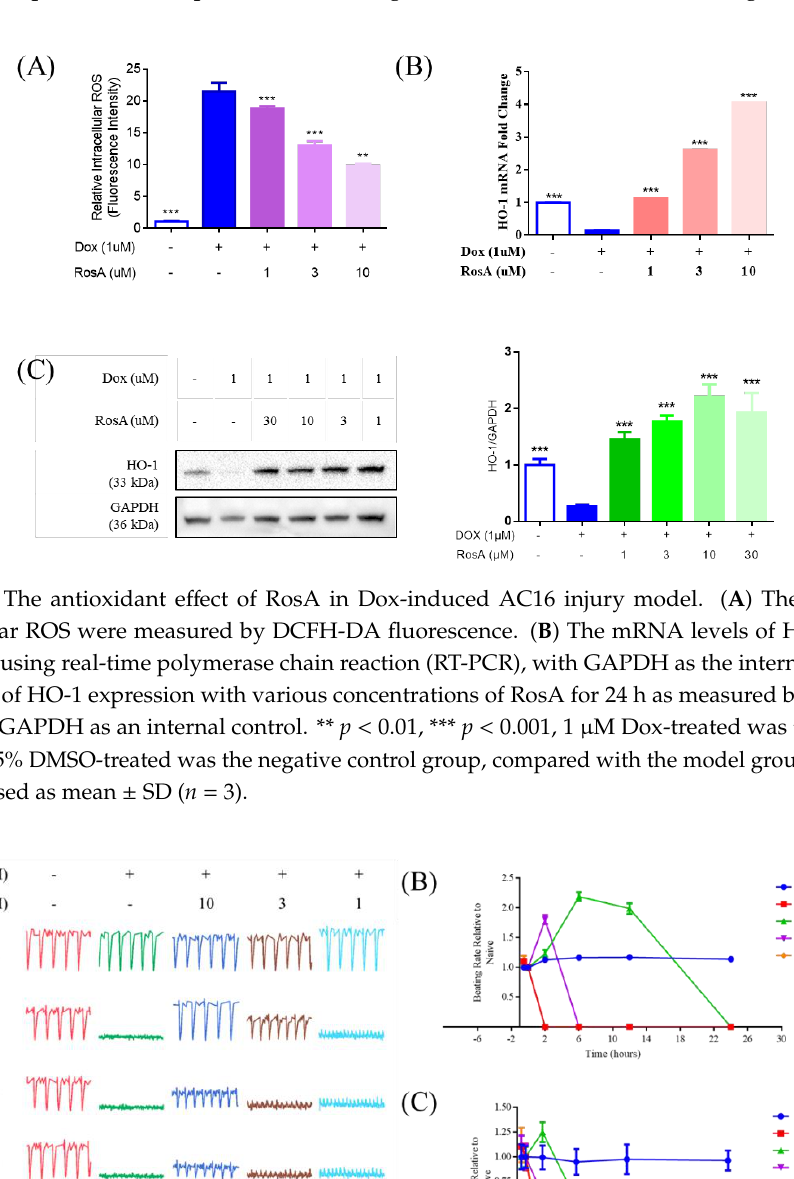
Figure 8. The myocardial protection of RosA in a Dox-induced hiPS-CMs injury model. ( A ) The levels of NT-proBNP and IL-6 were measured by ELISA. ( B ) The mRNA levels of NPPB and IL6 were evaluated using real-time PCR, with GAPDH as an internal control. ( C ) The levels of myocardial protection proteins, such as HDAC1, GATA4, and CTnI, were measured by Western blot, with β - tubulin as an internal control. * p < 0.05, ** p < 0.01, *** p < 0.001, ns: no significant difference. 1 μM Dox-treated was the model group; 0.25% DMSO-treated was the negative control group, compared with the model group. Results are expressed as mean ± SD ( n = 3). 3. Discussion The case study presented here illustrates the potential of phenotypic screening assisted by objective multivariable statistical methods. Pattern recognition techniques are particularly well suited to discriminate between phenotypes that are not easily described by a few parameters and were successfully applied previously for phenotypic profiling of drug effects [29]. The latter study applied a blind approach combining 11 probes to maximally cover the cellular biology and simultaneously test the complete dose-response [17]. For the analysis of mitochondrial morphology, unsupervised learning was used to define six morphological phenotypes in CHO cells and the effects of caspase inhibition [30]. Supervised learning was used to analyze mitochondrial morphology in BEAS-2B cells treated with CI and CII inhibitors [31]. Our study differs from the above ones since it extracts all morphology parameters to express the morphology change of cardio-/cytotoxicity induced by Dox as much as possible.